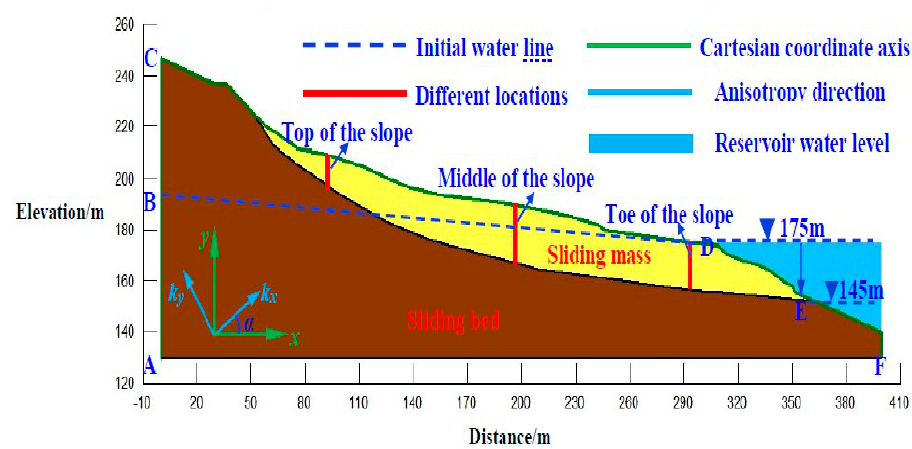
Figure 2. Illustration of slope model.